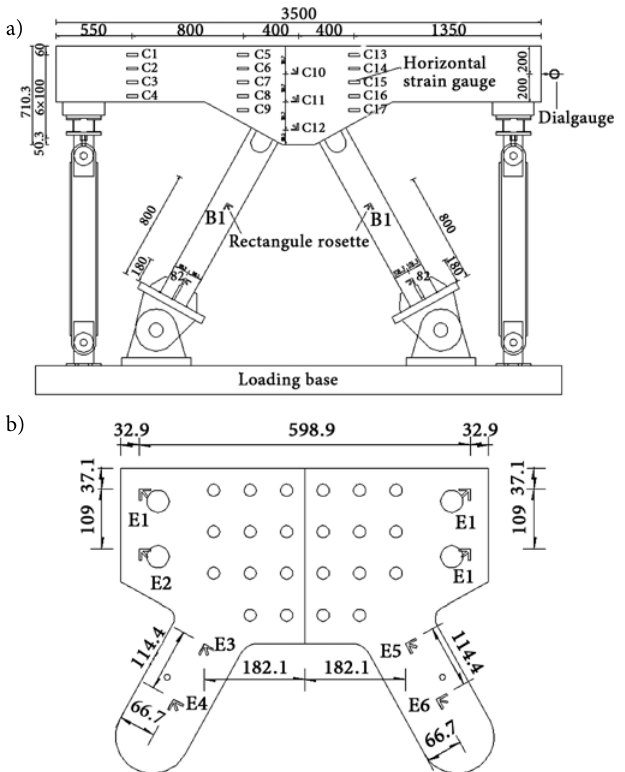
Fig. 5. Layout of joint displacement and strain gauging points (measurements in mm): a – front view of gauges on chord and web members; b – arrangement of gauging points on joint